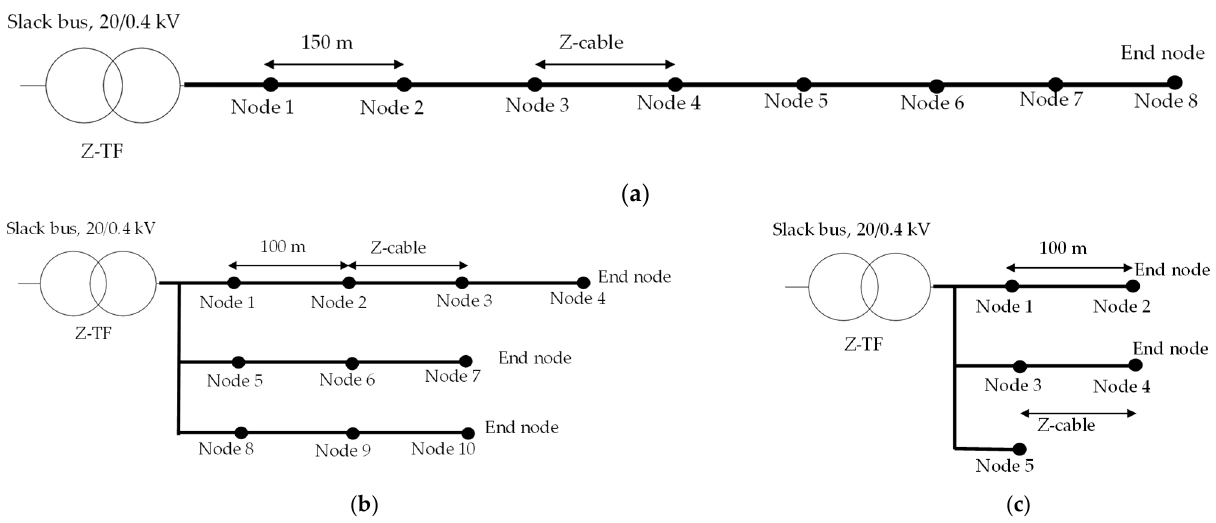
Figure 3. Network topology of three Finnish low voltage distribution networks: ( a ) Rural; ( b ) suburban; ( c ) urban .